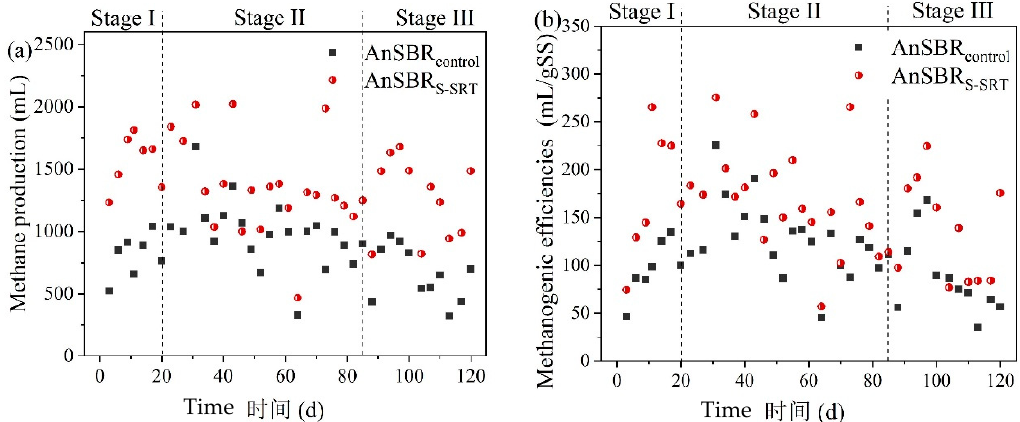
Figure 4. The anaerobic digestion performance of the two experimental AnSBRs ( a ). methane production, ( b ) methanogenic efficiency.